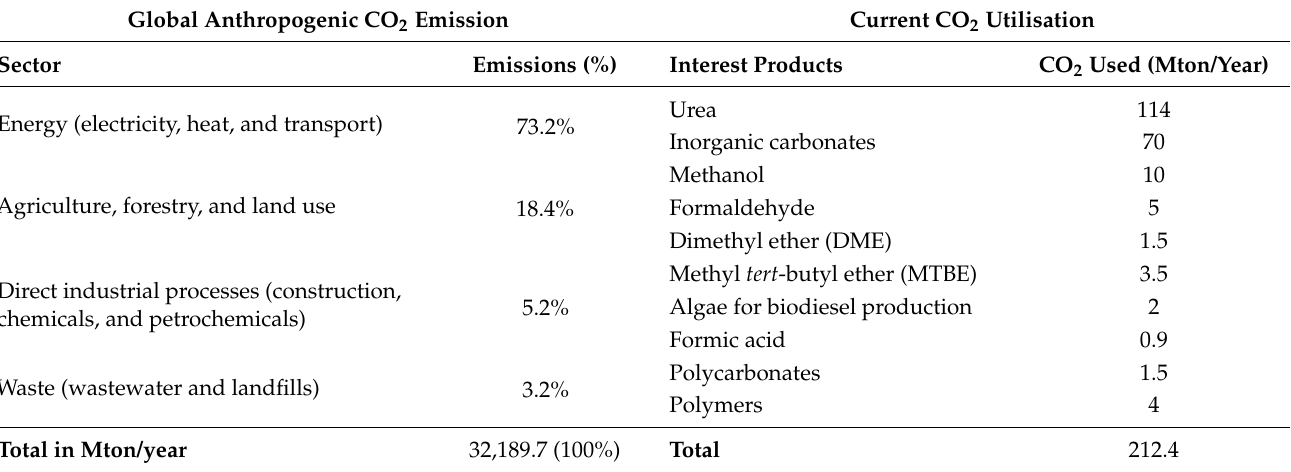
Table 1. Anthropogenic CO 2 emission by sector and conventional uses for producing chemicals. Adapted from references